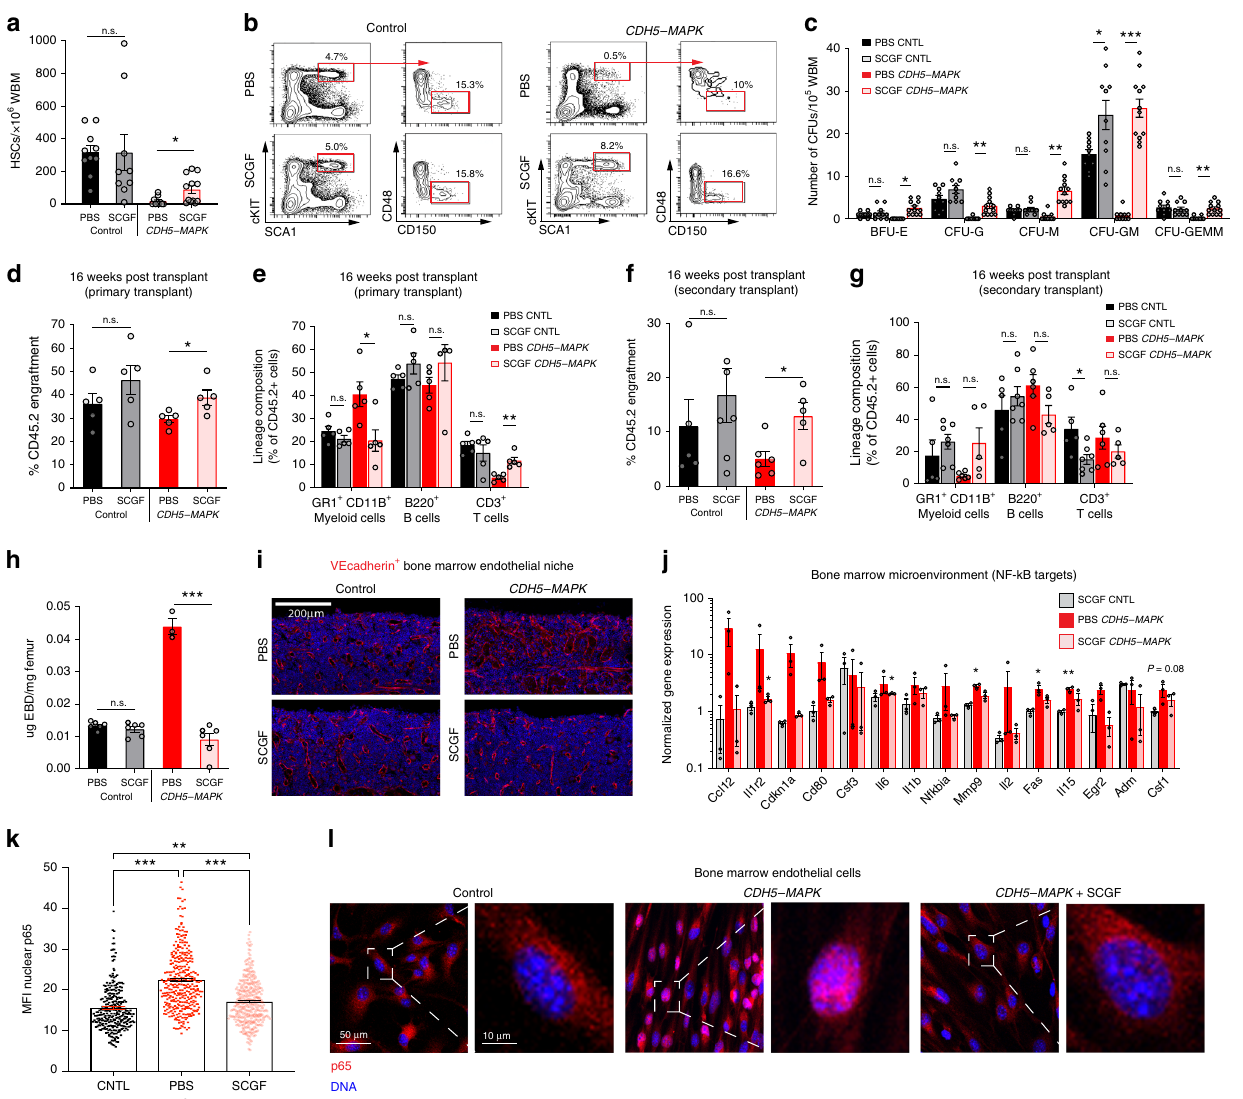
Fig. 8 SCGF infusion resolves hematopoietic and vascular defects in CDH5-MAPK mice. a Frequency of phenotypic HSCs per 10 6 WBM ( n = 9 – 10 mice/ cohort). b Representative contour plots demonstrating that SCGF infusion restores phenotypic HSC defects observed in CDH5-MAPK mice. c Methylcellulose-based progenitor assay ( n = 5 mice/cohort). d , e Competitive repopulation assay assessing total CD45.2 + cell engraftment and CD45.2 + lineage distribution 4 months post-transplantation ( n = 5 recipients/cohort; n = 5 donors per cohort). For competitive repopulation assays, 5× 10 5 donor WBM cells (CD45.2) were transplanted along with 5× 10 5 competitor WBM cells (CD45.1) into pre-conditioned CD45.1 recipient mice. Note that donor cells derived from SCGF-treated CDH5-MAPK mice displayed a signi fi cant increase in engraftment ef fi ciency with the resolution of the myeloid bias and increase in lymphoid output. Also, note that SCGF does not signi fi cantly impact the hematopoietic function or phenotype of control mice. f , g Secondary transplantation assay wherein WBM cells from long-term engrafted primary recipients were isolated and transplanted into pre-conditioned CD45.1 recipient mice (2× 10 6 donor WBM cells per recipient) ( n = 5 recipients/cohort; n = 5 donors per cohort). h Analysis of BM vascular leakiness by Evan ’ s Blue Dye (EBD) extravasation reveals that SCGF infusion signi fi cantly reduces vascular leakiness of CDH5-MAPK mice ( n = 3 – 5 mice/cohort). i Representative immuno fl uorescence images of femurs intravitally labeled with a vascular-speci fi c VECAD antibody (red) demonstrating reversal of vascular dilatation in CDH5-MAPK mice treated with SCGF. j Normalized gene expression of NF- κ B target genes within the BM microenvironment of indicated genotypes as compared to PBS-treated control mice. B2m was used for normalization ( n = 3 mice/cohort). k , l Representative immuno fl uorescence images and quanti fi cation demonstrating decreased levels of nuclear p65 in BMECs derived from CDH5-MAPK mice treated with SCGF. Error bars represent sample mean± SEM. Statistical signi fi cance was determined using two-tailed unpaired Student ’ s t -test for pairwise comparisons ( a – j ) and one-way ANOVA for multiple comparisons ( k ). * P ≤ 0.05; ** P <0.01; *** P < 0.001; n.s. P SCGF-treated CDH5-MAPK mice was also maintained during peripheral blood myeloid bias in CDH5-MAPK mice and restored secondary transplantation assays indicating a preservation of their blood counts (Supplementary Fig. 8d, e). Moreover, com- serial repopulation ability (Fig. 8f, g). Interestingly, the myeloid- petitive BM transplantation demonstrated that SCGF infusion biased output of CDH5-MAPK mice observed in primary trans- into CDH5-MAPK mice restored their long-term engraftment plantations was resolved in secondary transplantations indicating potential with a signi fi cant decrease in myeloid bias (Fig. 8d, e). that in fl ammation-induced lineage-skewing of HSCs is not The increased engraftment potential of BM cells derived from